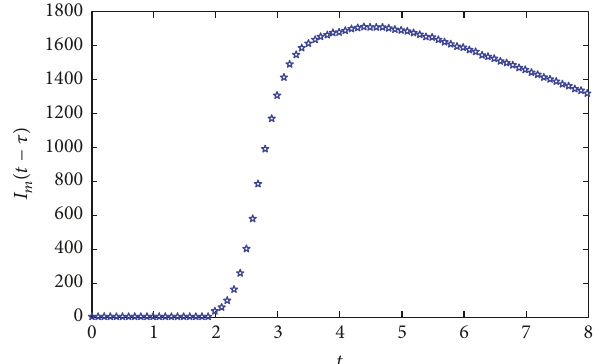
Figure 5: The relationship between 𝐼 𝑚 (𝑡) , 𝐼 𝑚 (𝑡−𝜏) with 𝜏 = 0.1 , 𝛼 = 0.95 using NSFDM.